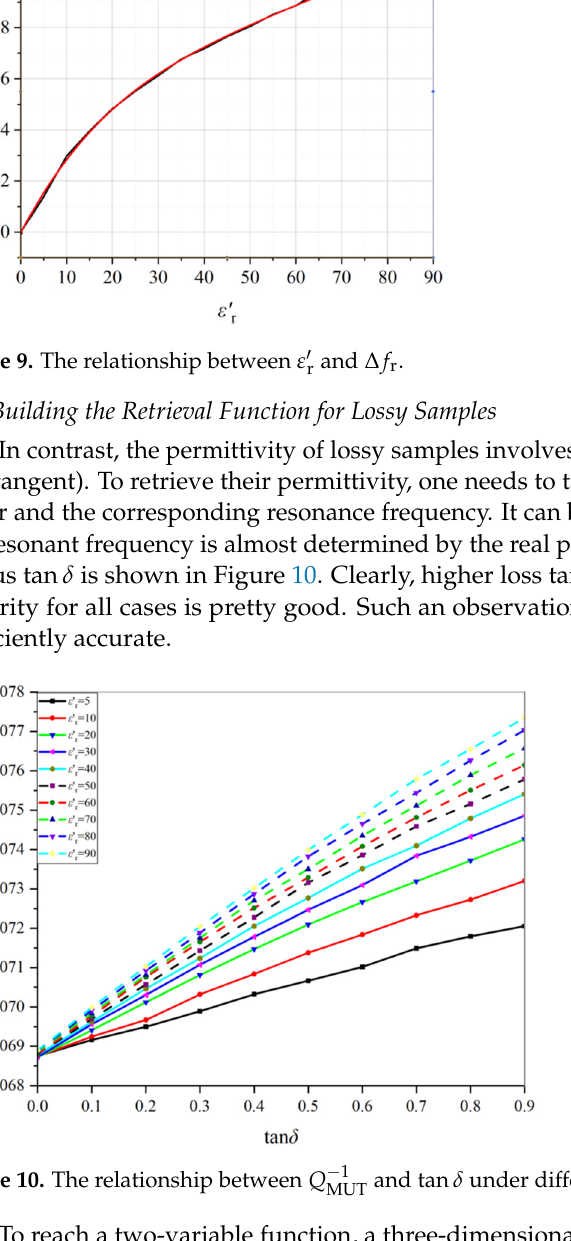
Figure 8. (dB) magnitude of sensor for